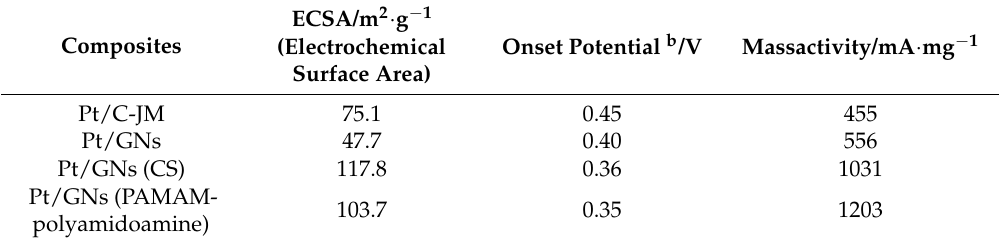
Table 1. Electrochemical parameters of as ‐ synthesized different composites a .